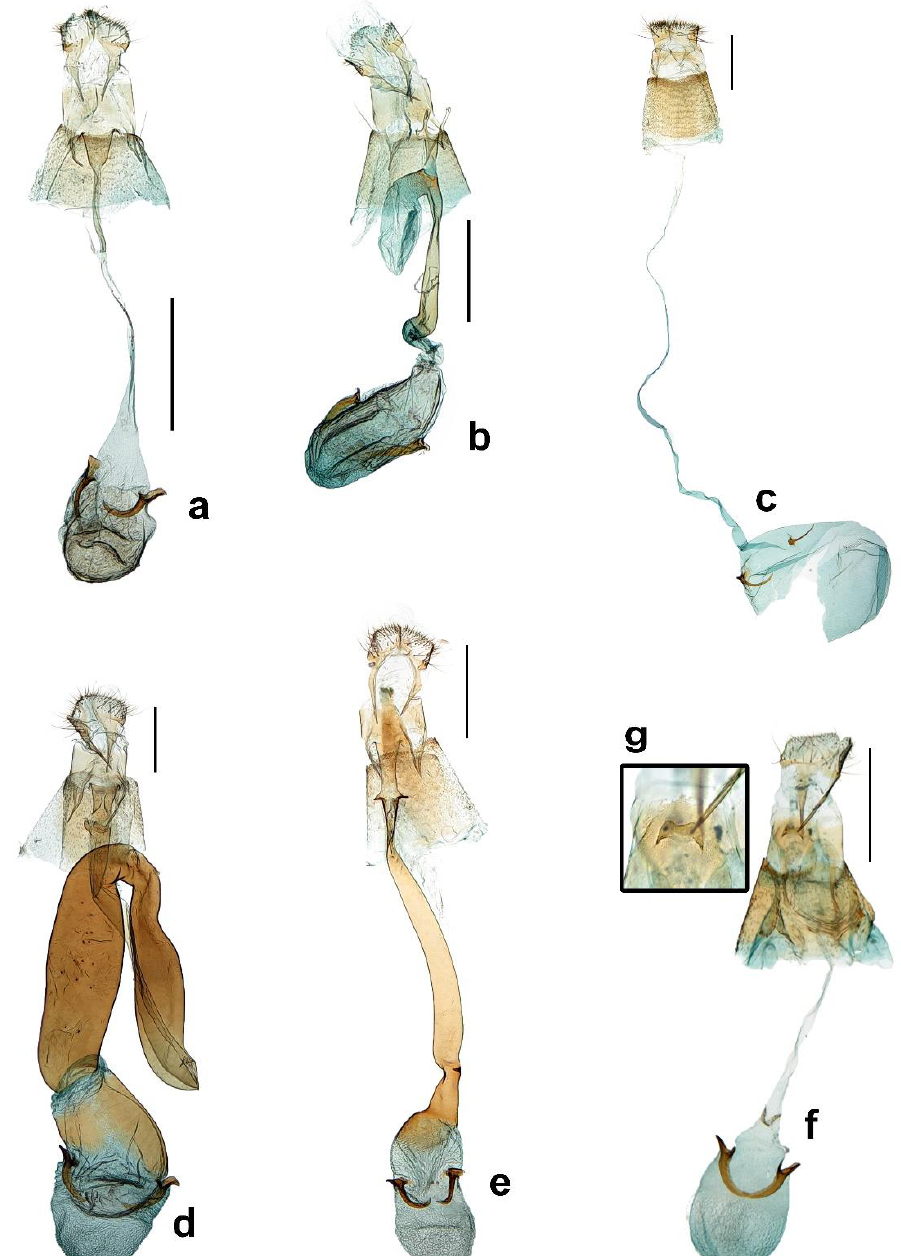
Figure 5. Female genitalia of Caloptilia . ( a ). C. acericola (gen. slide no. HNUSEL-5574); ( b ). C. celtidis (gen. slide no. HNUSEL-5613) ( c ). C. kadsurae (gen. slide no. HNUSEL-5558); ( d ). C. monticola (gen. slide no. HNUSEL-5587); ( e ). C. recitata (gen. slide no. HNUSEL-5543); ( f ). C. soyella (gen. slide no. HNUSEL-5597); ( g ). ditto, antrum (Scale bars: a–d = 5 mm). 3.2.3. Caloptilia dentata Liu & Yuan, 1990 Ne-mo-mu-nui-ga-neun-na-bang Caloptilia (Caloptilia) dentata Liu & Yuan, 1990: 186 [20]. TL: Beijing, China. TD: IZAS Material examined. [GG] 1 ♀ , Korea National Arboretum, Gwangneung, 20 May 2008 (Holotype; Paratypes). (leg. SY Park, BW Lee, SR Kim, DH Kwon), gen. slide no. HNUSEL-5577-coll. KNAE; Adult (Figure 4c). Forewing length 5 mm. [GW] 3 ♂ , 2 ♀ , Mt. Odae, 27 May 1991 (leg. BK Byun), gen. slide no. NAK-533, HNUSEL- Male genitalia (Figure 5603, 5604-coll. HNUSEL; 1 ♂ , Mt. Odaesan, Jinbu-Myeon, Pyeongchang, 20 June 2012 (leg. SY Park, JO Lim, JS Lim), gen. slide no. HNUSEL-5608-coll. KNAE; [CB] 1 ♂ , Mt. Minjuji, Maegok-myeon, Yeongdong-gun, 22 May 2014 (leg. IJ Choi, JW Nam, MH Kim), gen. slide no. HNUSEL-5571-coll. KNAE; 1 ♂ , Namwon-si, Sannae-myeon, Jeongnyeongchi 23 May